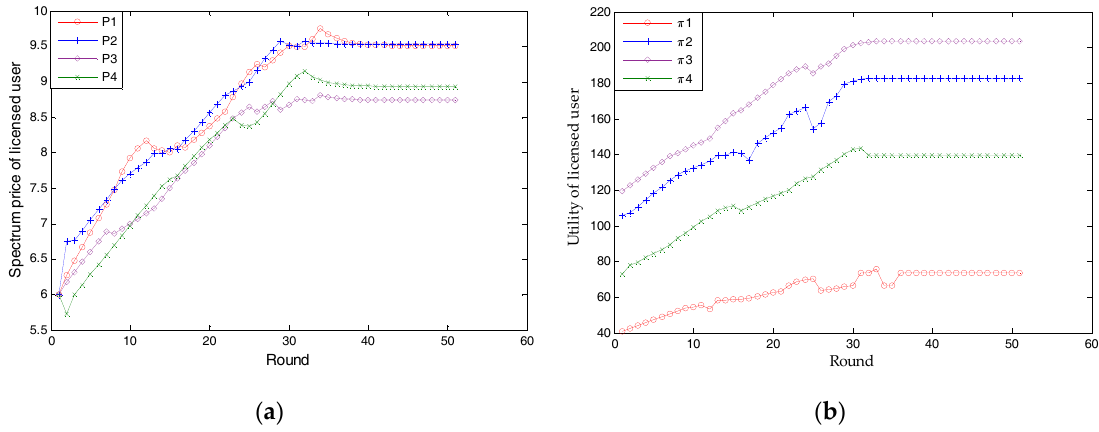
Figure 6. The process of finding Nash bargaining solution (NBS): ( a ) spectrum price; ( b ) utility of licensed user.